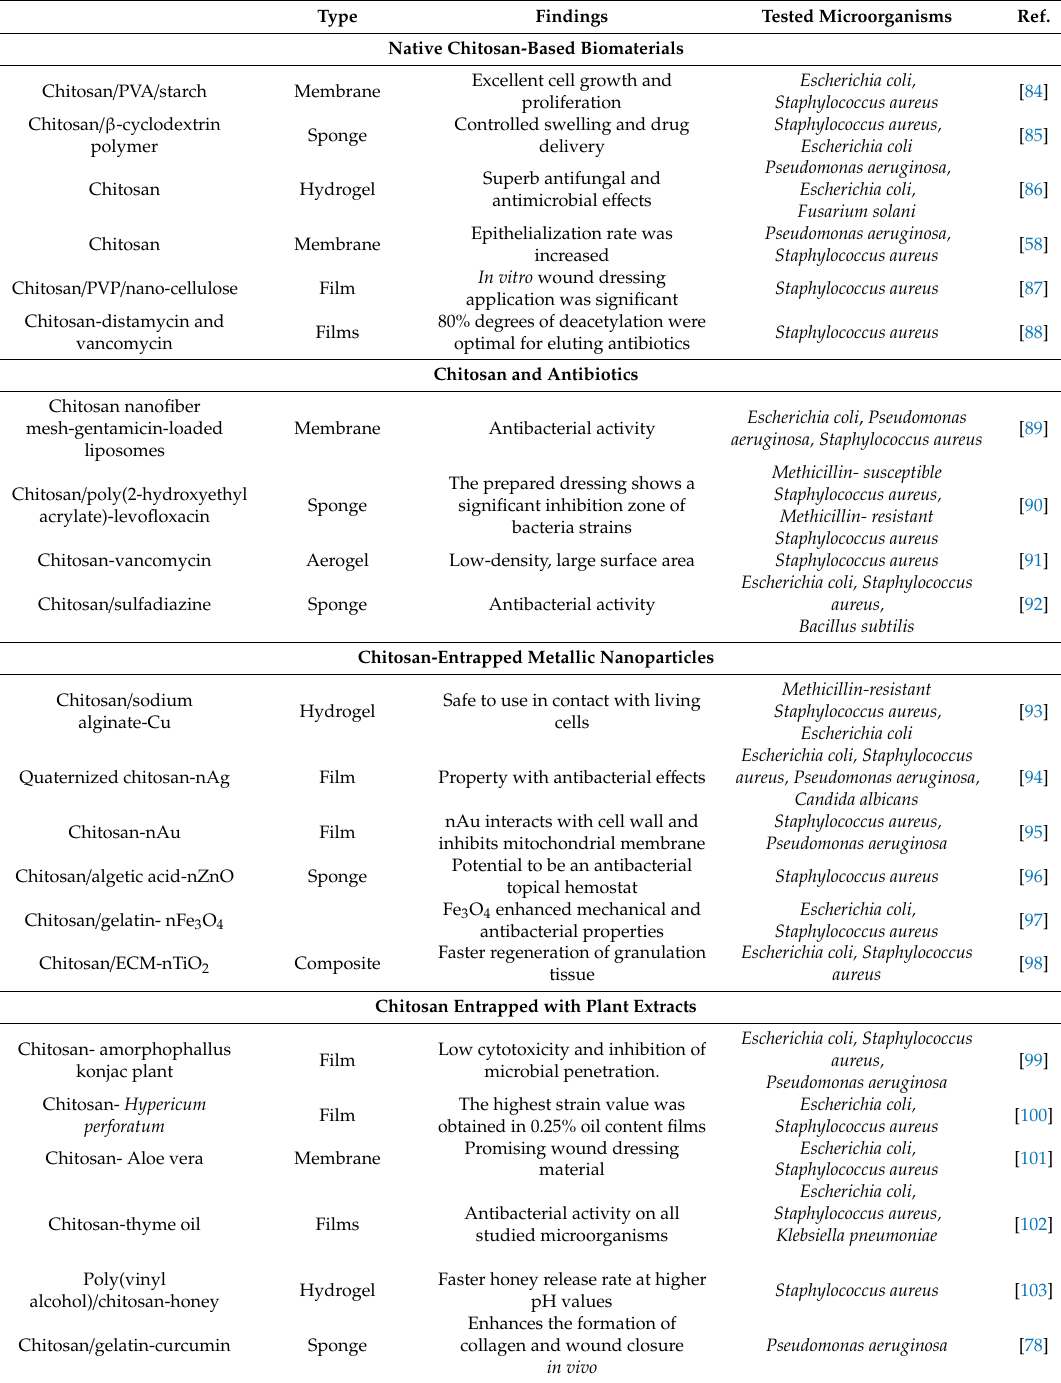
Table 4. Recent chitosan-based wound dressings prepared either as native chitosan or modified and formulated with other antimicrobial